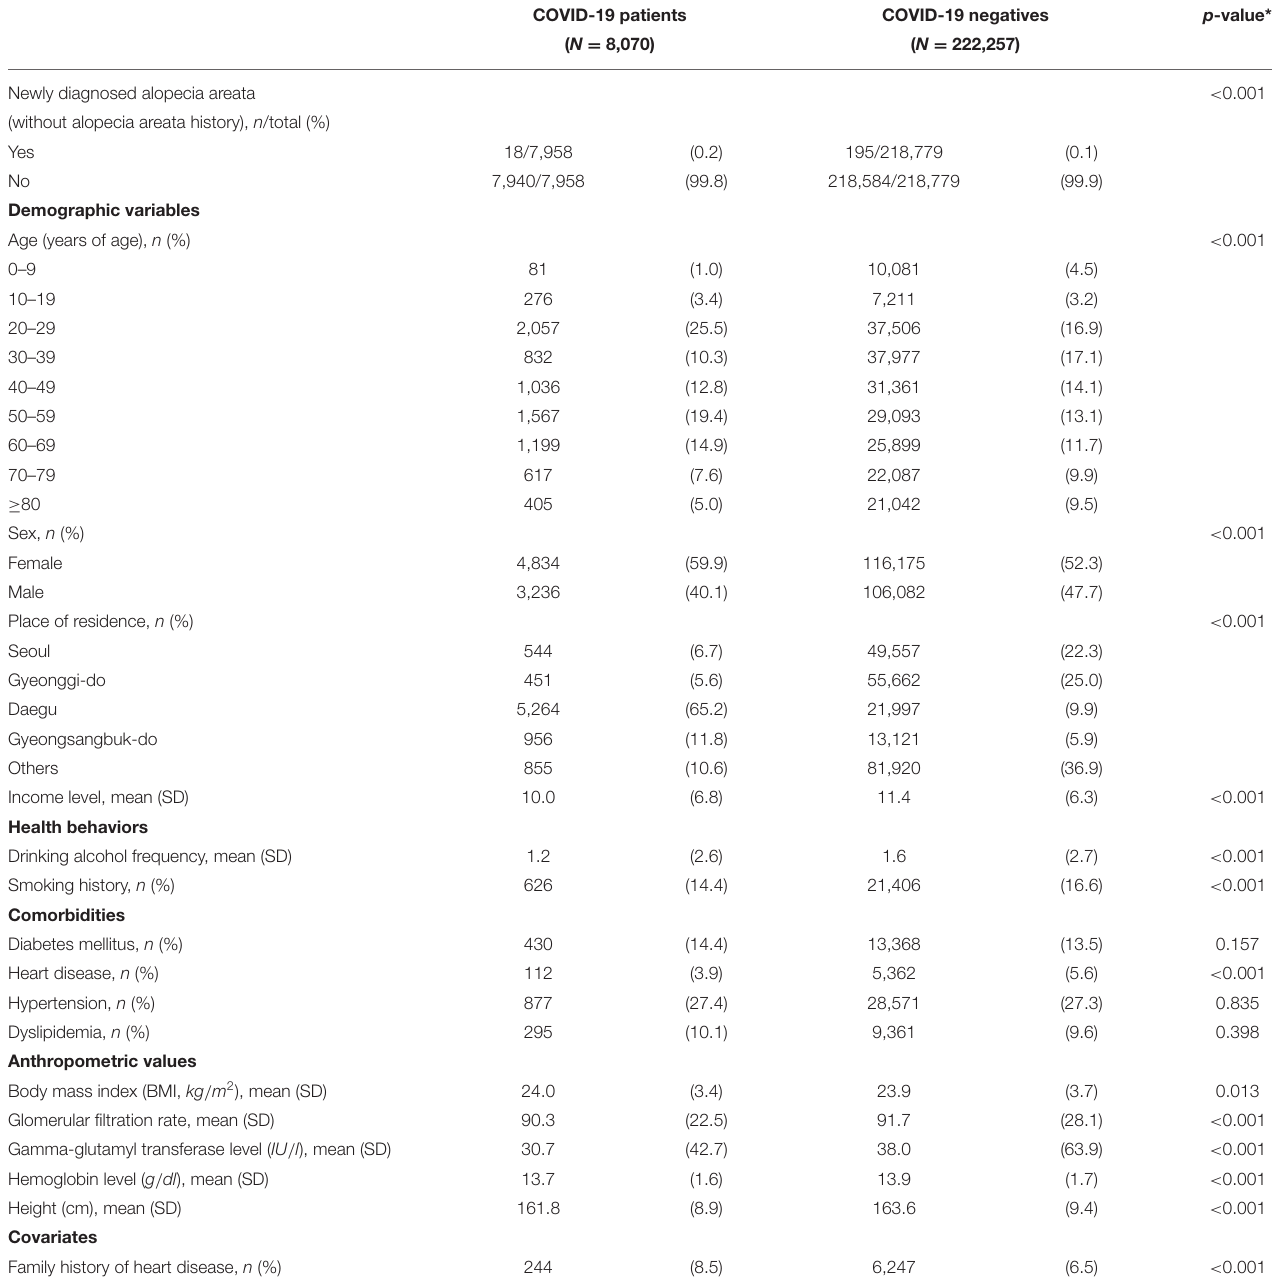
TABLE 1 | Demographics of study